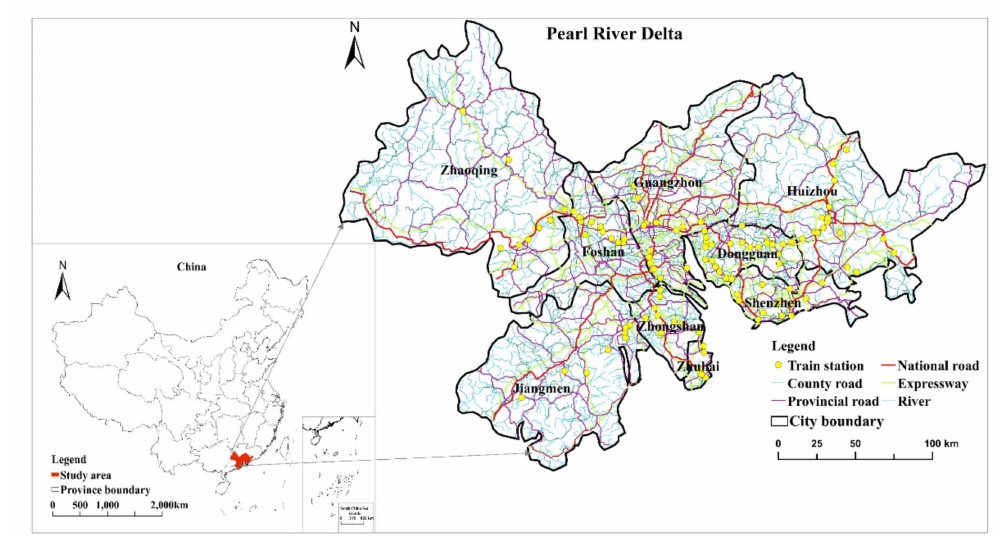
Figure 1. Location of the PRD